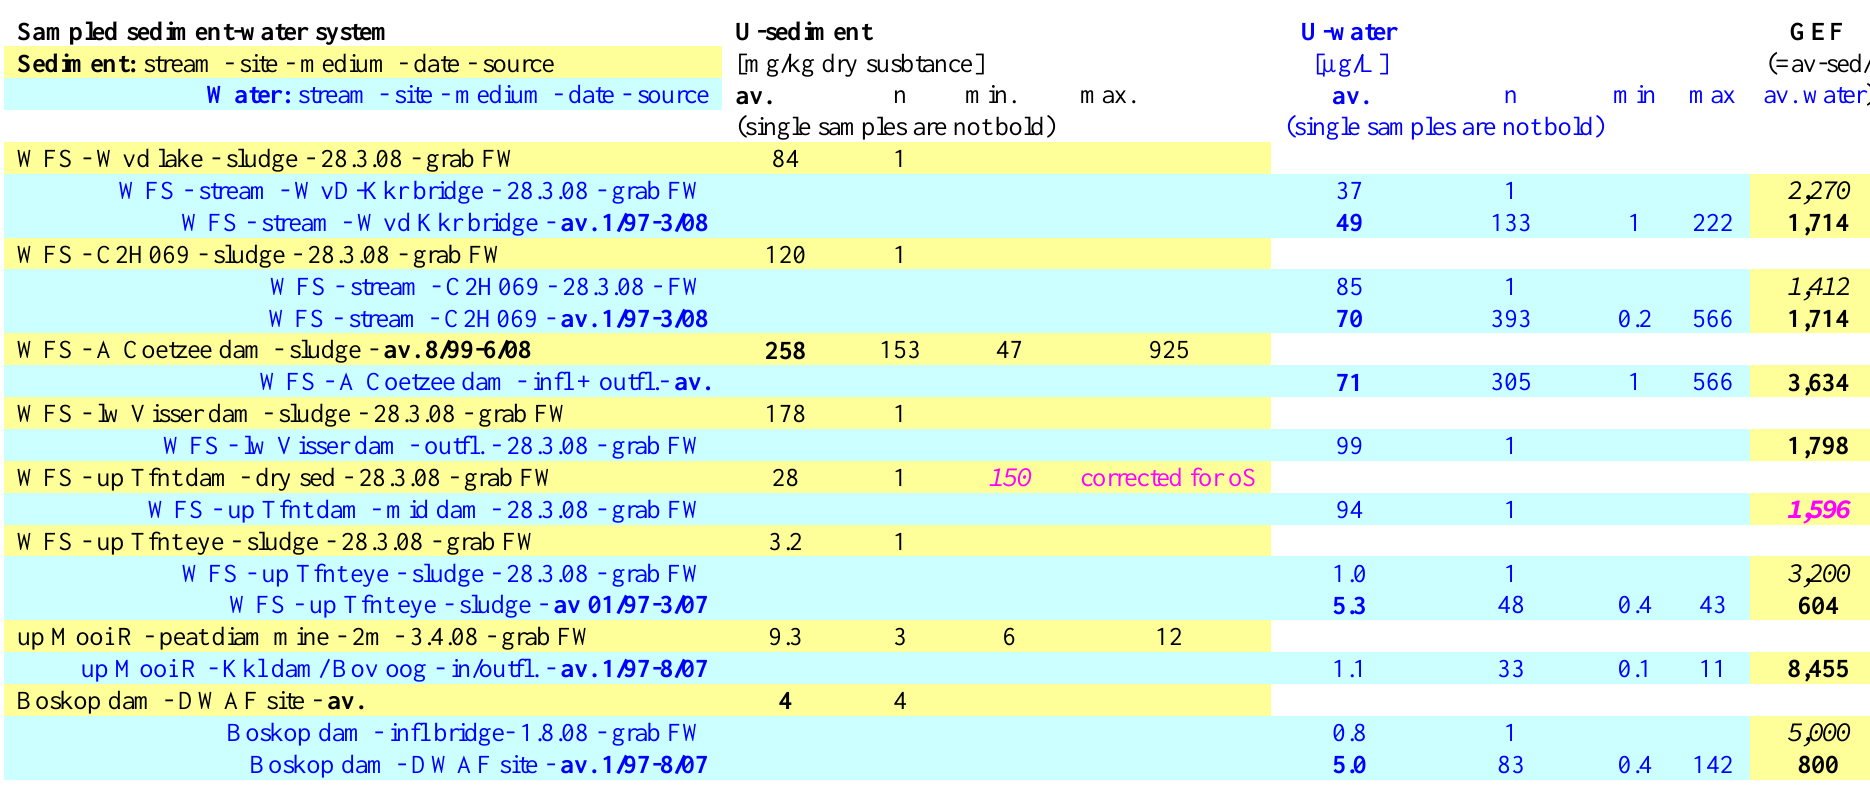
Table 4. Geochemical enrichment factors (GEF) for different water-sediment systems in the lower Wonderfonteinspruit and upper Mooi River. GEFs printed in italics are based on single grab water sample rendering them unreliable. Where available, therefore, long-term average U concentrations in the corresponding water body are preferentially used for interpretation (GEFs are printed in bold